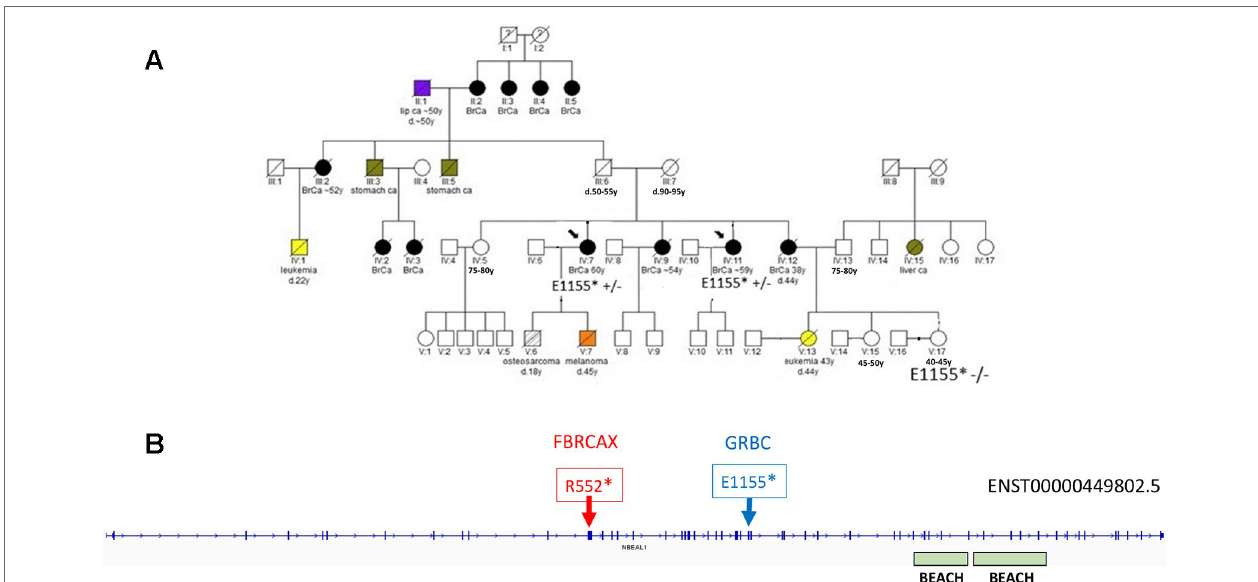
FIGURE 4 | (a) Segregation of NBEAL1 :E1155* in GRBC pedigree F22. Two sisters (diagnosed with BC at 59 and 60 years) were heterozygous carriers of the NBEAL1 stop-gain variant. Their niece, who was cancer-free at 40 years of age, was not a carrier of the variant. (B) Genomic positions of NBEAL1 LoF variants detected in GRBC ( NBEAL1 :E1155*) and FBRCAX ( NBEAL1: p.R552*) patients. Variants were experimentally validated using Ampliseq (GRBC) and Sanger sequencing (FBRCAX).